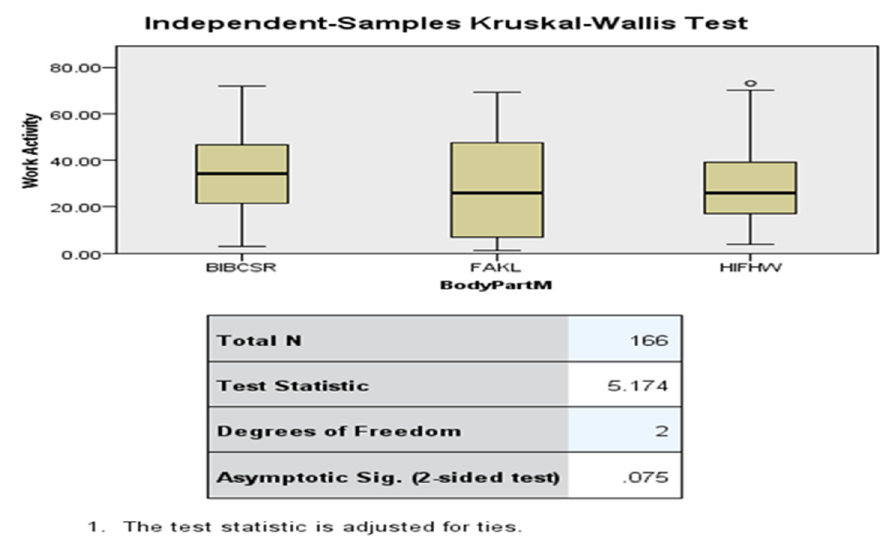
Figure 2. Independent samples Kruskal–Wallis Test for H 01 . Source: own elaboration.